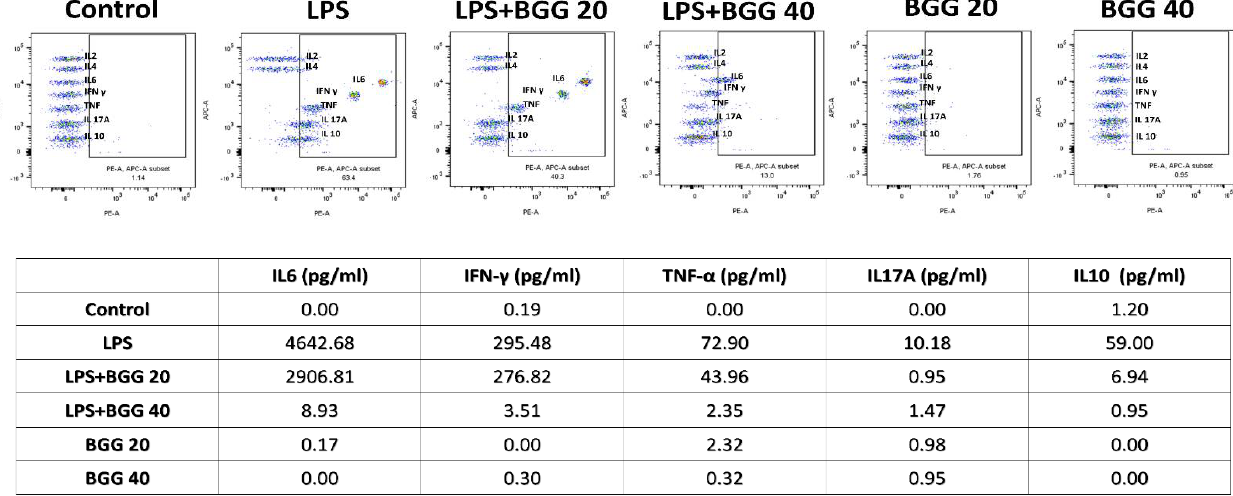
Figure 18. Measuring extracellular cytokine interleukins by CBA bead assay analyzed by using flow cytometry in mice